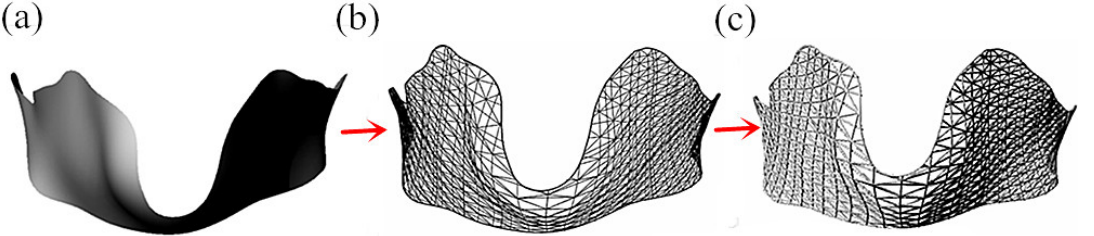
Figure 5. Design process of multi-layer grid structure for thyroid cartilage prosthesis after total resection: ( a ) Surface model; ( b ) Line model; ( c ) Volume model.